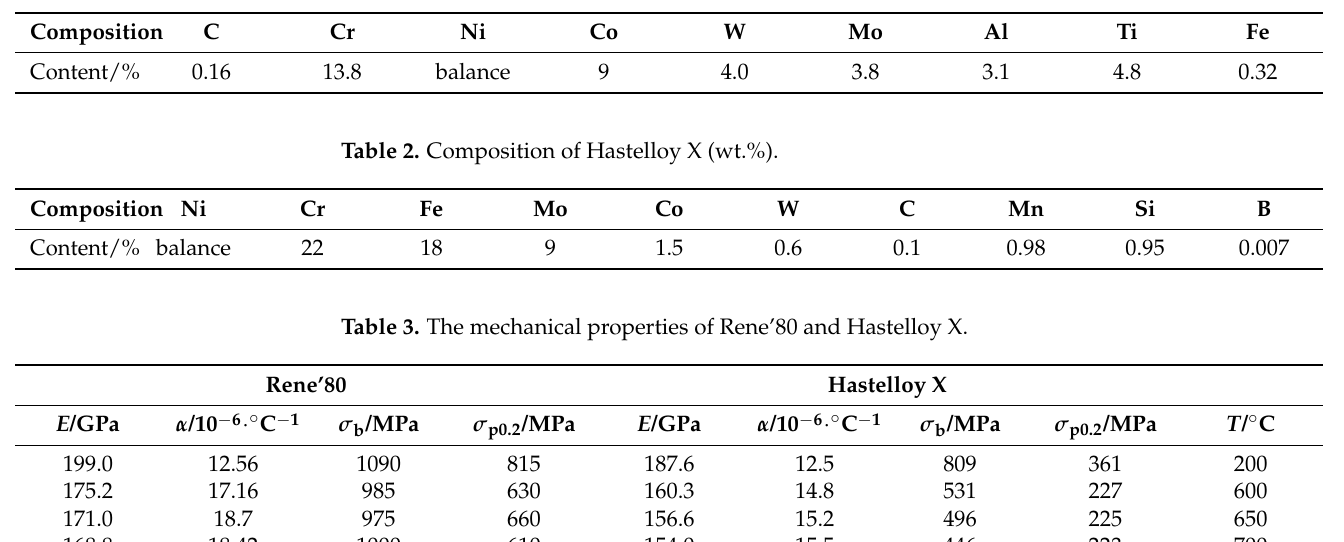
Table 1. Composition of Rene’80 (wt.%).